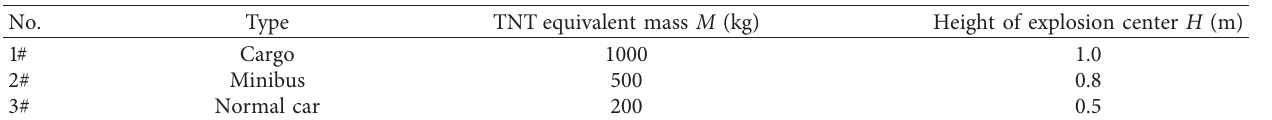
Table 1: Types and properties of car